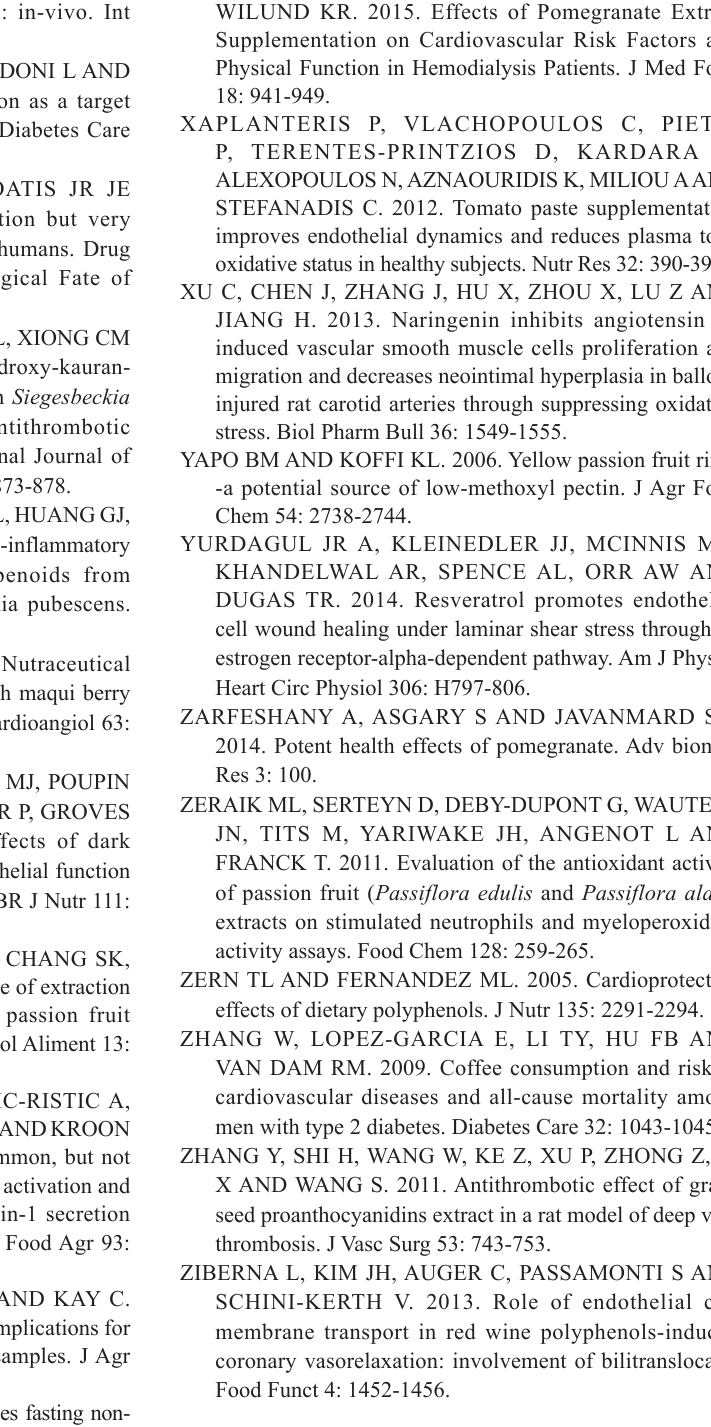
Table SI - Endothelial cell protection and natural bioactive